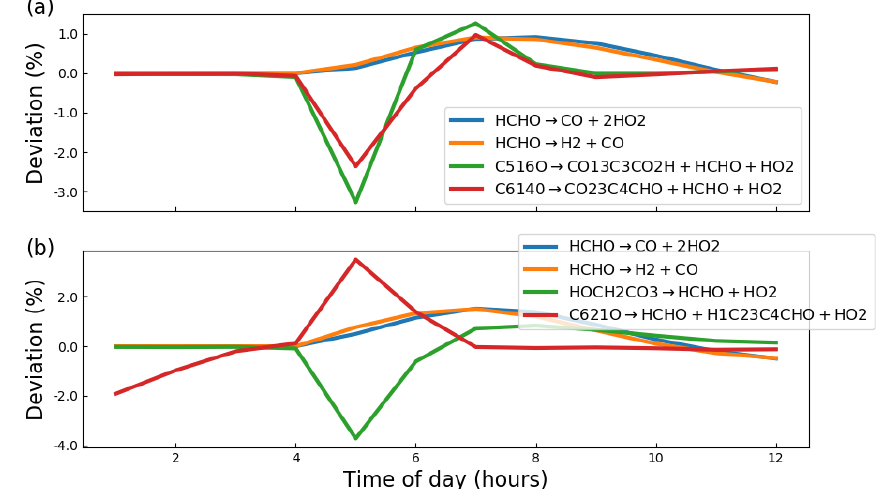
Figure 4. Deviation of PyCHAM change tendency (rate of change due to individual chemical reactions) for formaldehyde (HCHO) from AtChem2 simulations for the MCM reactions given in the legends (the loss and production channels of formaldehyde with the greatest deviation). The definition for deviation is given by Eq. (4). Both plots are results for the α -pinene ozonolysis reaction described in the main text for Fig. 3 (a) in the presence of NO x and (b) in the absence of NO x .